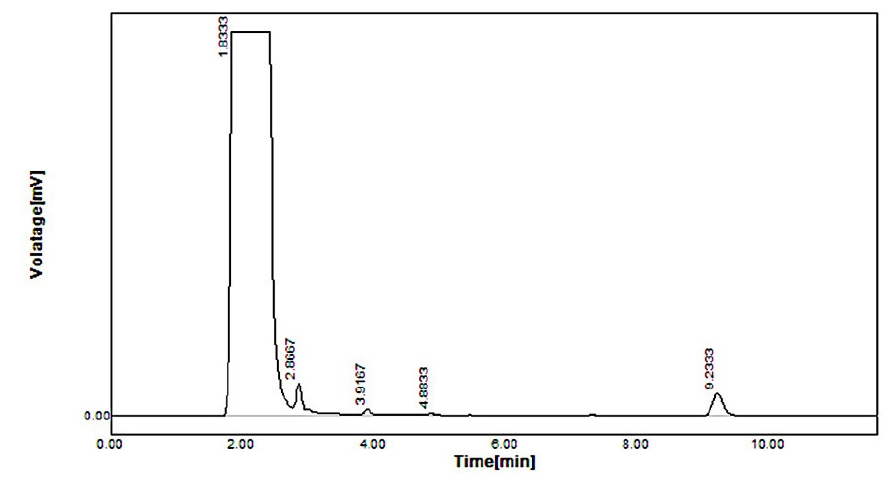
Table 4. Pharmacokinetic parameters of simvastatin and simvastatin acid (metabolite) in pure drug and nanoformulation.